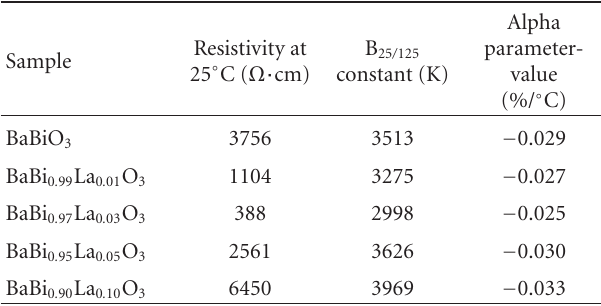
Table 1: Resistivity at 25 ◦ C, B 25 / 125 constant, and temperature coe ffi cient of resistance for the samples sintered at 750 ◦